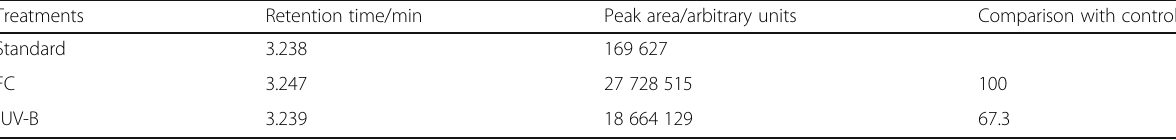
Table 2 HPLC peak area and retention time of saponin in cotton leaves extracts Treatments Retention time/min Peak area/arbitrary units Comparison with control/%